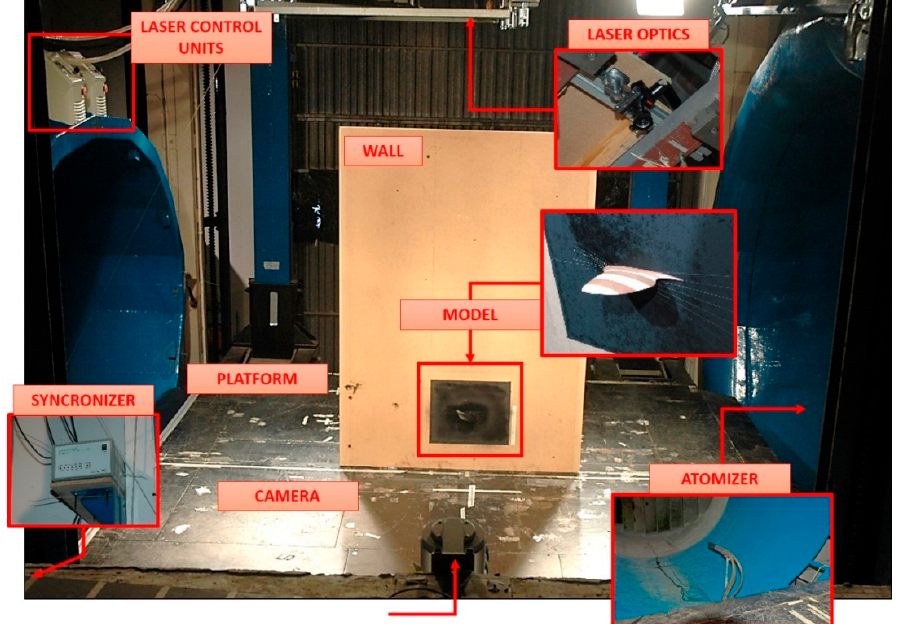
Figure 1. Experimental Setup.